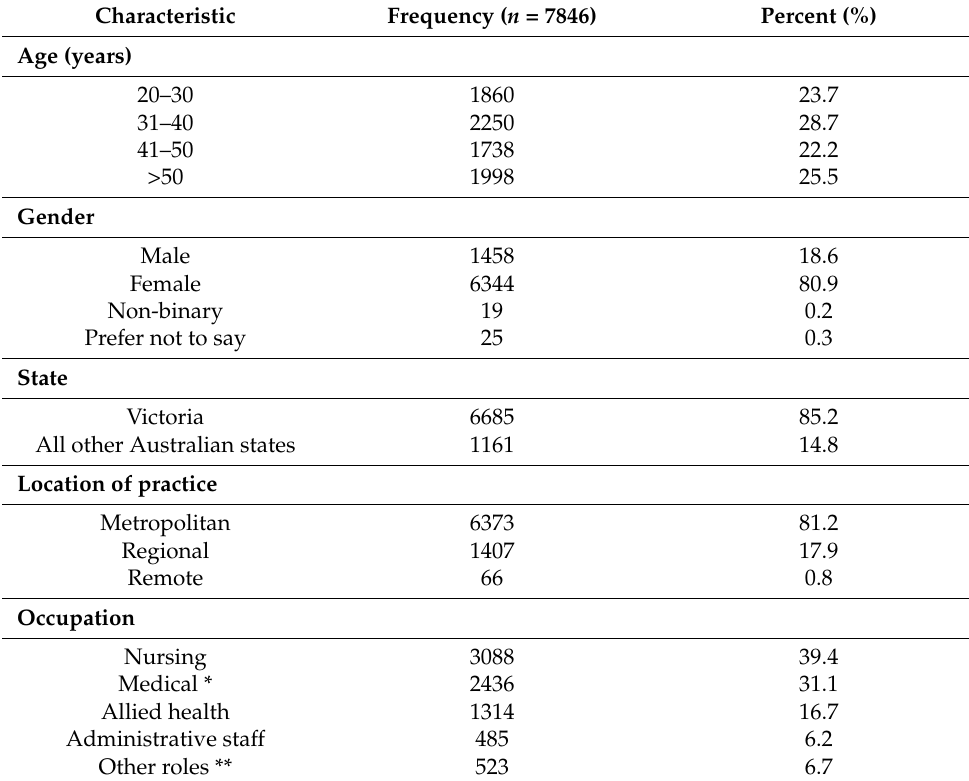
Table 1. Participants’ characteristics.